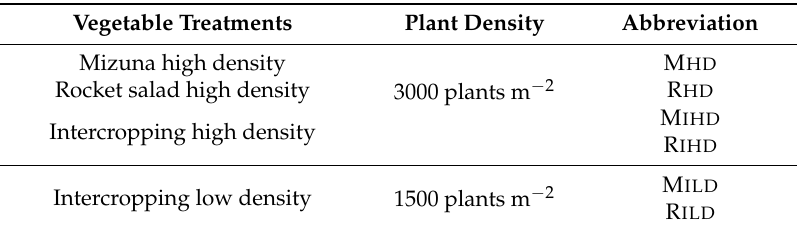
Table 2. Vegetable treatments and their